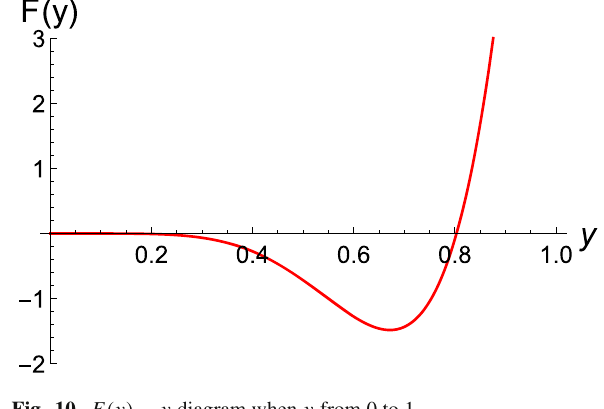
Fig. 10 F ( y ) − y diagram when y from 0 to 1